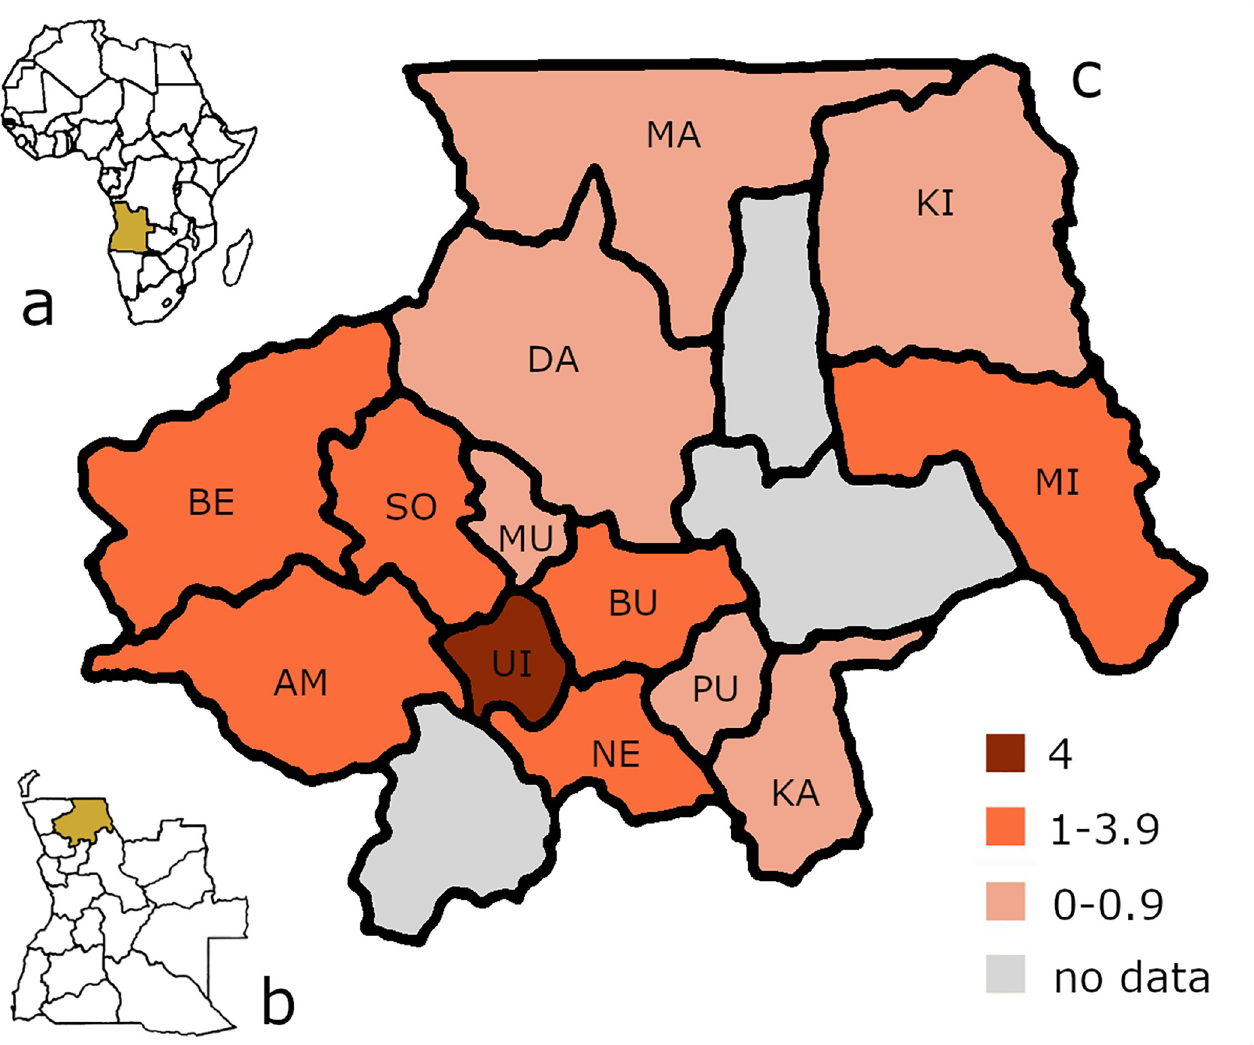
Fig 1. Average plant species number. (a) Location of Angola in Africa (map based on https://landlook.usgs.gov/landlook/viewer.html), (b) Province of Uı´ge in Angola (map based on https://commons.wikimedia.org/wiki/File:Covid19-angola.jpg), (c) Average number of plant species used in cemeteries in the different surveyed municipalities (map based on